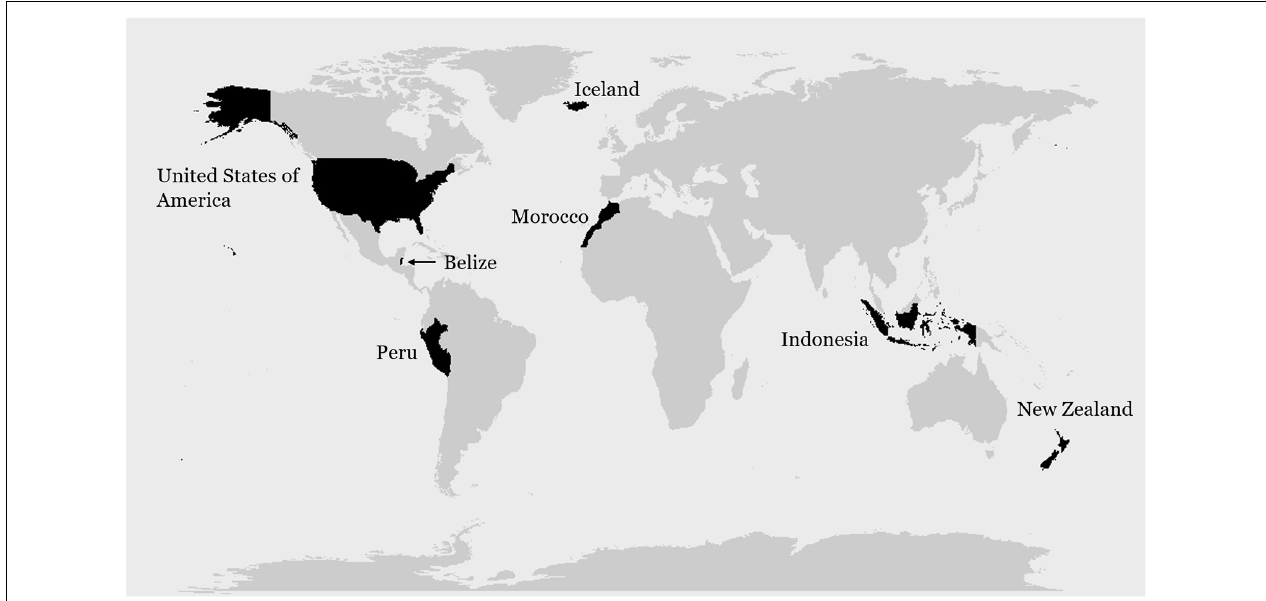
FIGURE 1 | Countries (in black) where interviews were